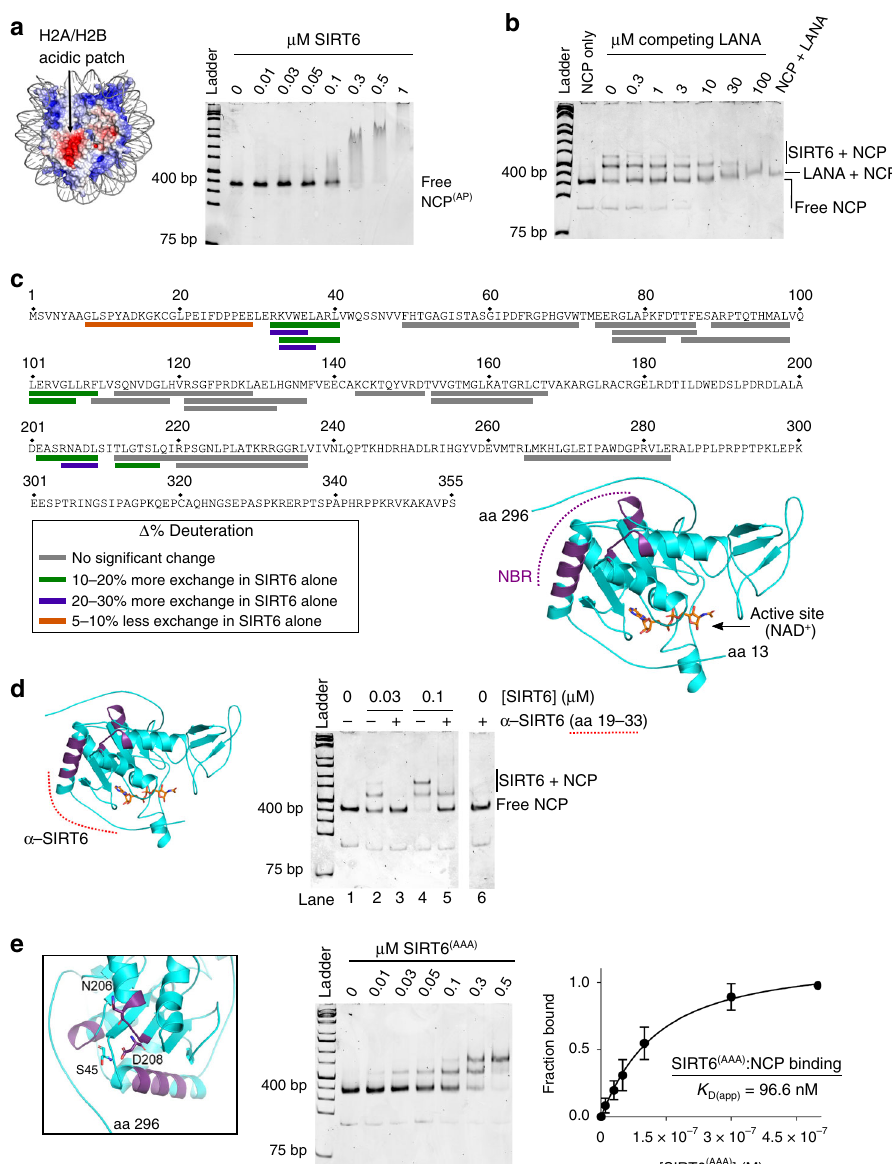
Fig. 2 SIRT6 and nucleosomes interact through speci fi c regions. a Surface depiction of the nucleosome (3lz0.pdb 64 ) with electrostatics generated by the APBS plugin for PyMOL 65,66 . One acidic patch on one side of the NCP is indicated. NCPs assembled with four alanine mutations at the acidic patch (NCP (AP) ) exhibited weaker binding to SIRT6. The image is representative of three independent experiments. b In the LANA peptide competition EMSA, SIRT6:NCP complexes were prepared with 100 nM SIRT6 and 50 mM NCP, then competed with LANA peptide. The image is representative of three independent experiments. c HDX-MS analysis of differential peptide exchange in the SIRT6:nucleosome interaction. SIRT6 residues that are protected against exchange when bound to NCPs are highlighted in green and purple colors in the primary sequence, and in purple in the structure of SIRT6 (3pkj. pdb 8 ). NAD + (nicotinamide adenine dinucleotide) is included to indicate the active site. d An antibody that recognizes SIRT6 amino acids 19 – 33 (red dashed line) was used to probe SIRT6 binding to NCPs. When pre-bound to SIRT6, the antibody disrupts formation of both the 1:1 and 2:1 SIRT6: nucleosome complexes. The image is representative of three independent experiments. e The zoomed image displays amino acids mutated to alanine (SIRT6 (AAA) ) for native gel analysis. The residues occupy loops that reside around a speci fi c interface. On the right, EMSA of SIRT6 (AAA) binding to nucleosomes shows a weakened binding af fi nity. Data are presented as mean ± s.d. from four independent experiments. Source data are provided as a source data fi